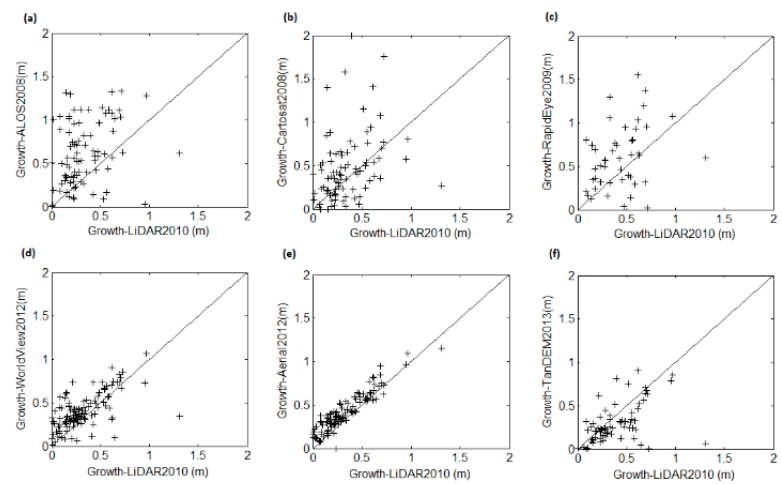
Figure 11. Tree growth detected from: ALOS2008 ( a ); Cartosat2008 ( b ); RapidEye2009 ( c ); WorldView2012 ( d ); Aerial 2012 ( e ); and TanDEM-X2013 ( f ) ( n = 137).